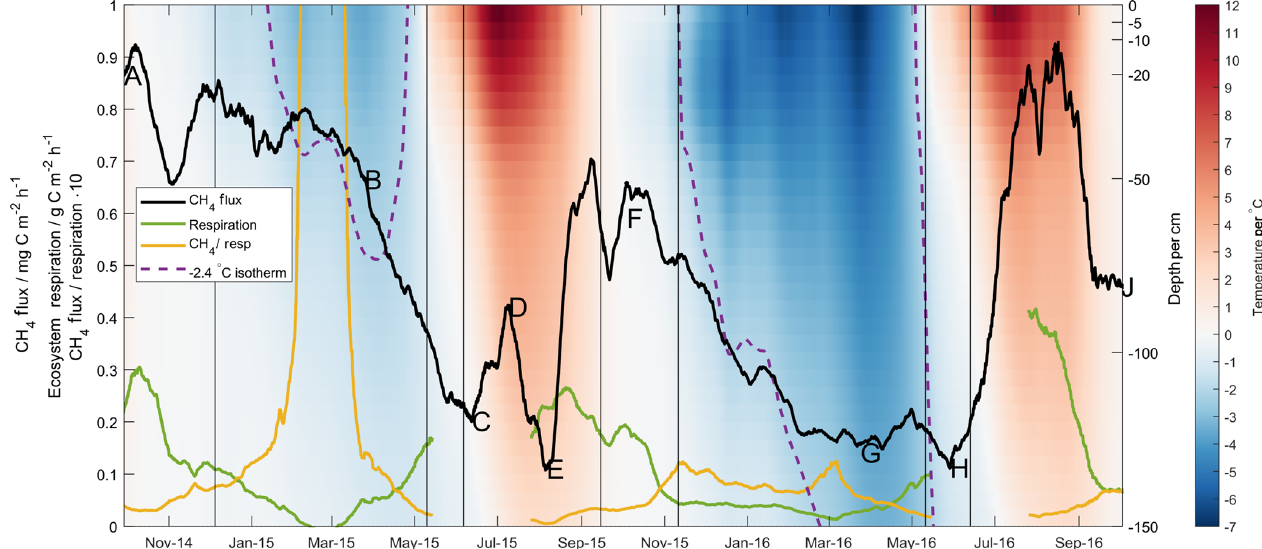
Figure 4. The 28d moving average methane (black line) and ecosystem respiration (green line) fluxes, along with the ratio of the two (yellow line). Lettering corresponds in time to that given in Fig. 2. Shading gives soil temperature as measured at Toolik Field Station according to depth (right axis). Purple dotted line shows the depth of the − 2 . 4 ◦ C